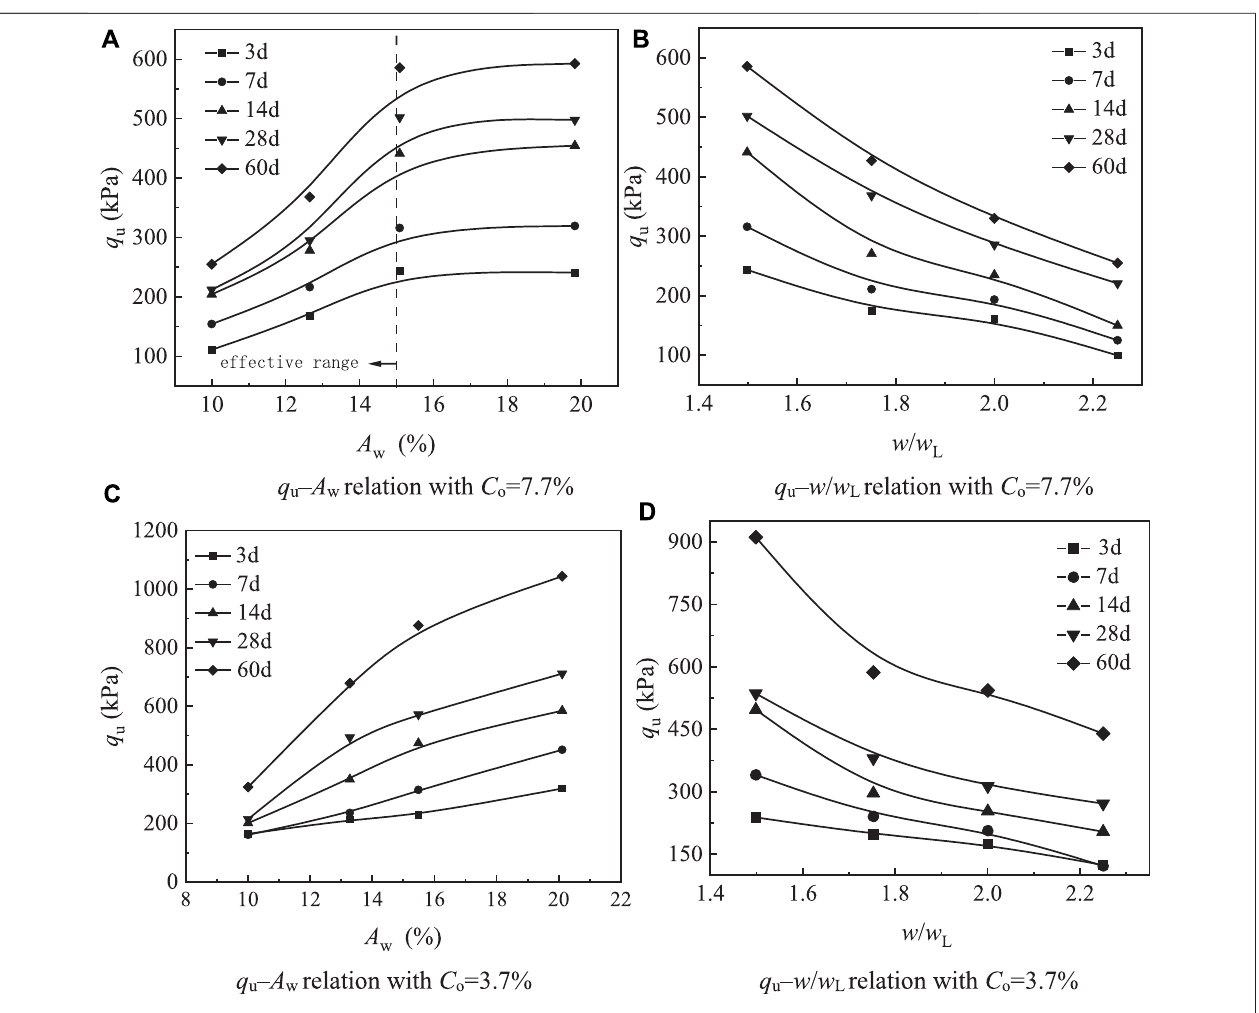
FIGURE3| Compressivestrength q u plottedwithrespecttocement incorporation ratio A w and initialwatercontent w . (A) q u – A w relation with C o =7.7% (B) q u – w / w L relation with C o = 7.7%. (C) q u – A w relation with C o =3.7% (D) q u – w / w L relation with C o =3.7%.